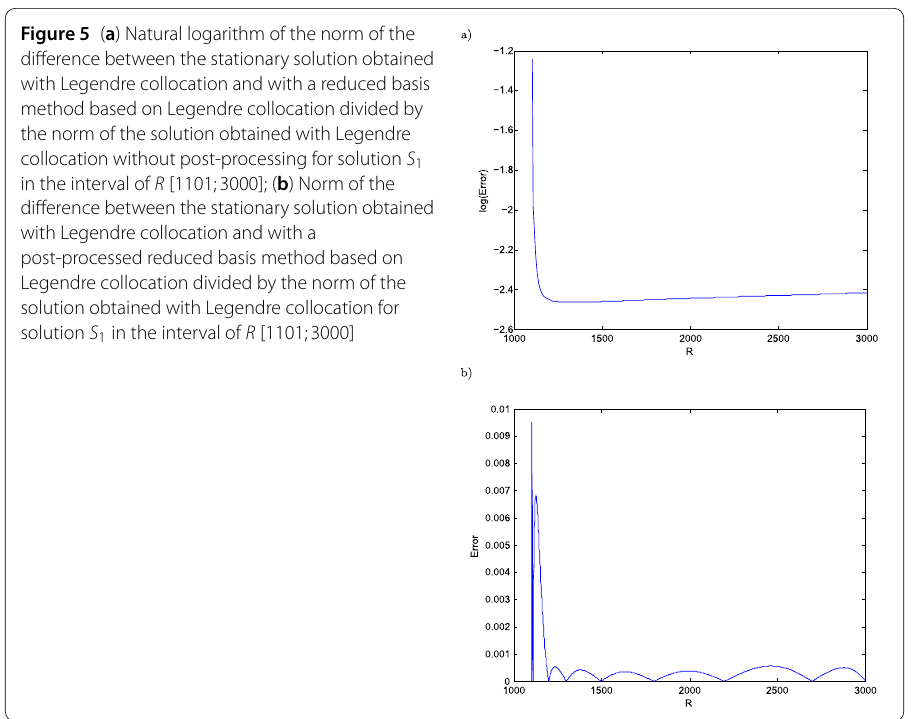
Figure 5 ( a ) Natural logarithm of the norm of the difference between the stationary solution obtained with Legendre collocation and with a reduced basis method based on Legendre collocation divided by the norm of the solution obtained with Legendre collocation without post-processing for solution S 1 in the interval of R [1101;3000]; ( b ) Norm of the difference between the stationary solution obtained with Legendre collocation and with a post-processed reduced basis method based on Legendre collocation divided by the norm of the solution obtained with Legendre collocation for solution S 1 in the interval of R